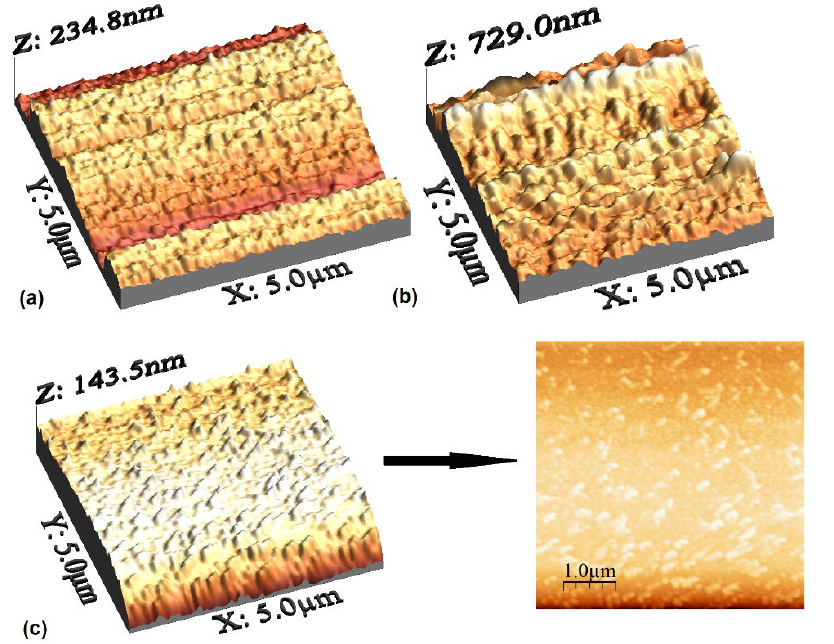
Figure 5. AFM images of ( a ) I-CuPc, ( b ) I-CoPc and ( c ) I-ZnPc films.